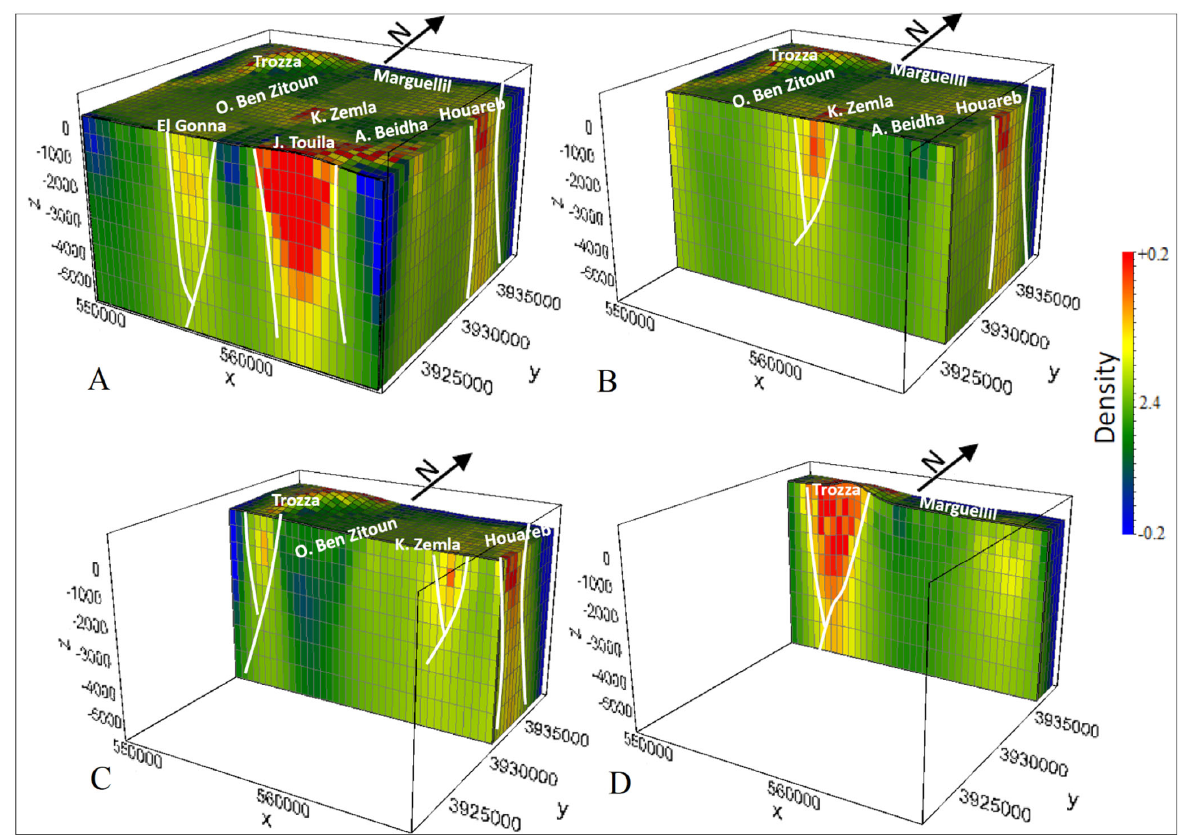
Figure 9. Interpreted 3D density inversion model using the lateral cutting plane of the Ain El Beidha plain. (A) Lateral cutting across El Gonna and Touila structures. (B) Lateral cutting across Oued Ben Zitoun, Kroumet Zemla and Ain El Beidha. (C) Lateral cutting across southern Trozza Mountain, northern Oued Ben Zitoun syncline and northern Kroumet Zemla fold. (D) Lateral cutting across Trozza Mountain and northern Ain El Beidha plain.